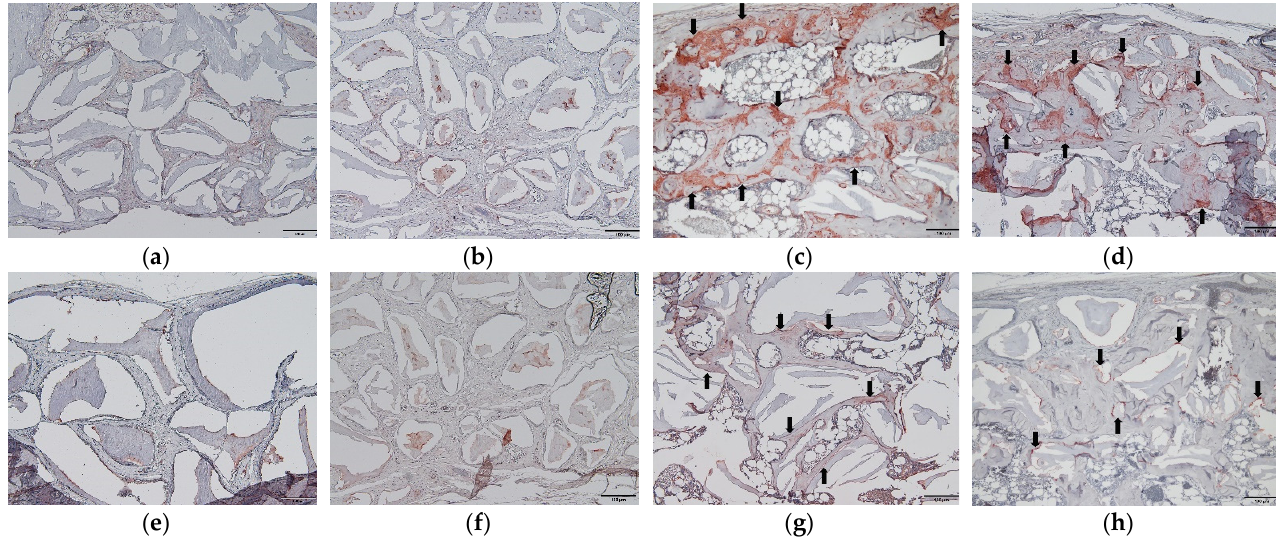
Figure 6. Immunohistochemical staining of bone sialoprotein (BSP) and osteocalcin observed in each group. (BSP; a – d ) and osteocalcin ( e – h ) at 6 weeks after the operation. ( a , e ) particle (P), ( b , f ) block (B), ( c , g ) P+bone morphogenetic protein (BMP), and ( d , h ) B+BMP. A high expression of BSP and osteocalcin was observed in the new bone matrix of the P+BMP and B+BMP groups and is indicated by black arrows (Original magnification 100×, bar = 100 μ m).